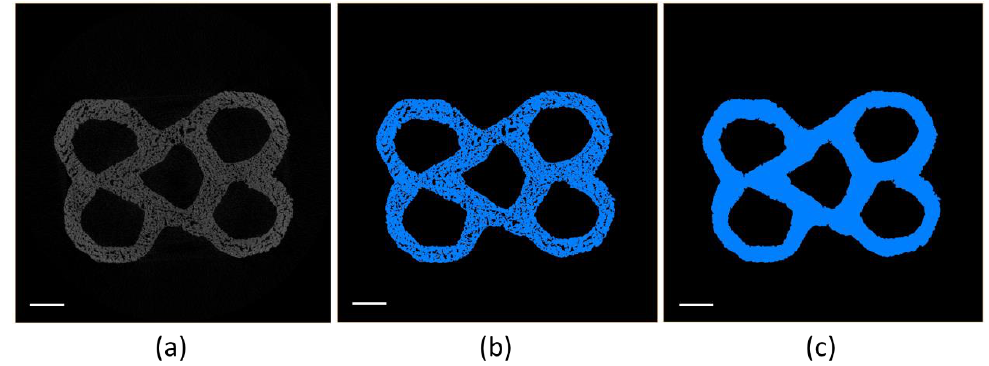
Figure 4. Representation of the image processing step for a honeycomb structure with cell size of 10 mm and wall thickness of 1.3 mm (H4): ( a ) cross-section of the original reconstructed volume, ( b )